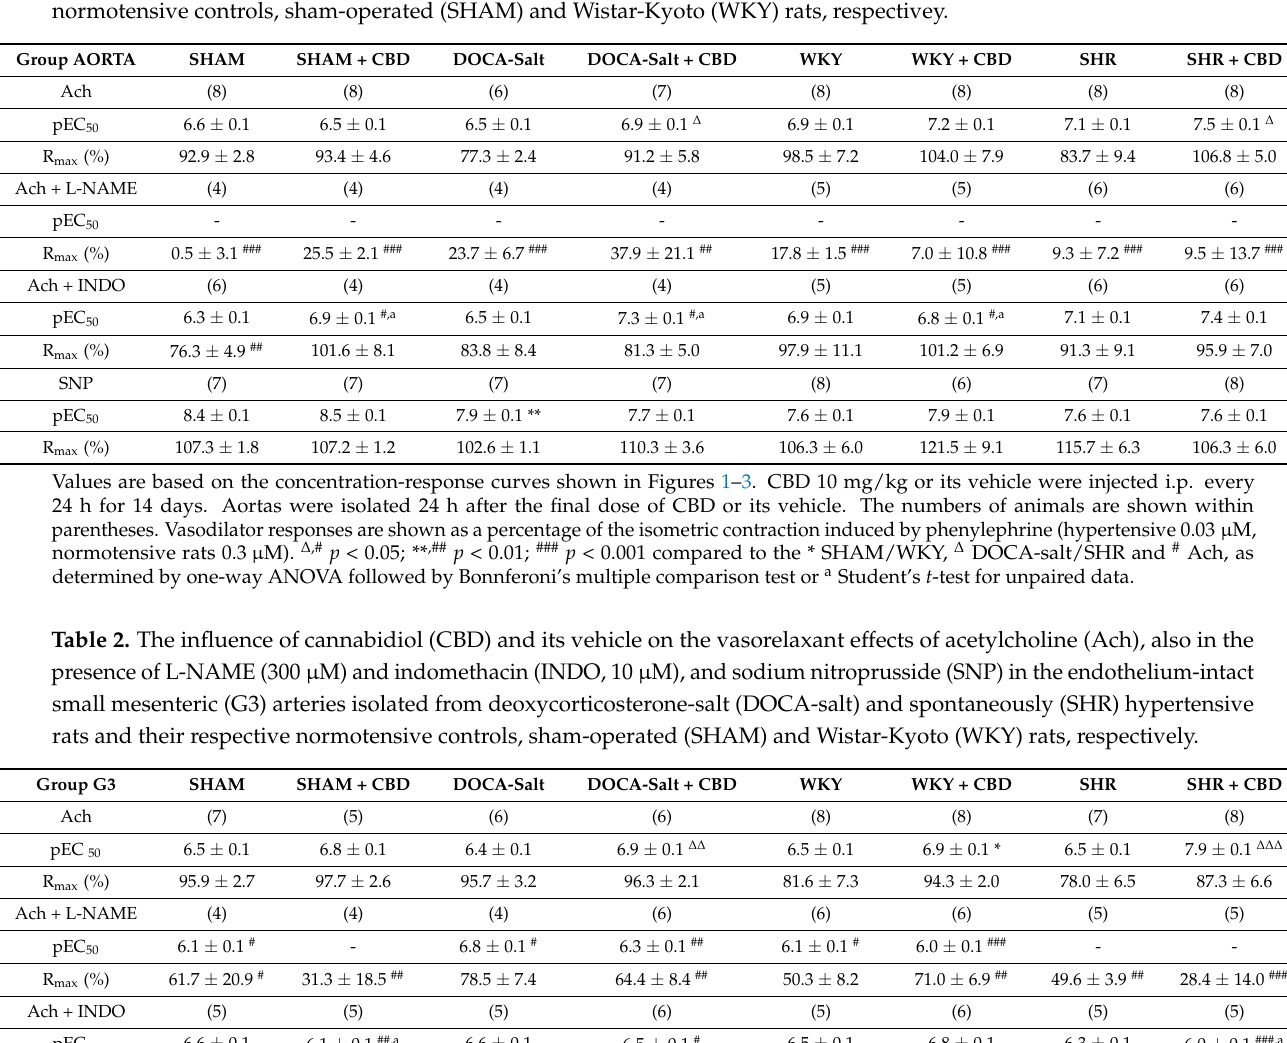
Table 1. The influence of cannabidiol (CBD) and its vehicle on the vasorelaxant effects of acetylcholine (Ach), also in the presence of L-NAME (300 µ M) and indomethacin (INDO, 10 µ M), and sodium nitroprusside (SNP) in the endothelium-intact aortas isolated from deoxycorticosterone-salt (DOCA-salt) and spontaneously (SHR) hypertensive rats and their respective normotensive controls, sham-operated (SHAM) and Wistar-Kyoto (WKY) rats, respectivey. Group AORTA SHAM SHAM + CBD DOCA-Salt